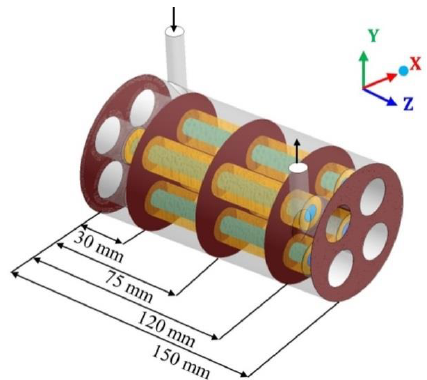
Figure 4. Transverse planes, in the hull region, chosen for data analysis.